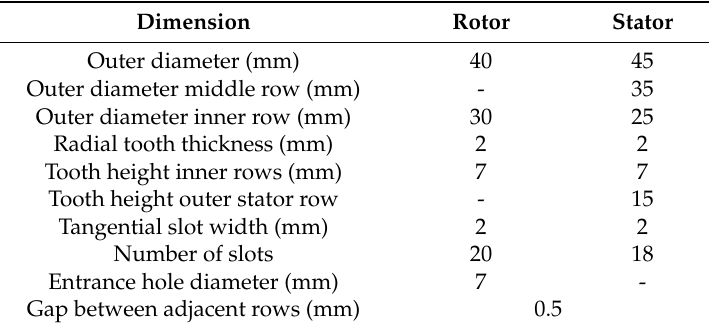
Figure 2. Rotor ( left ), stator ( middle ), and assembly ( right ). Important dimensions are given in Table 1. The clearance between the teeth and opposite base plate is small and somewhat dependent on the tightening of the screw. It was taken to be 0.1 mm in the simulations. Table 1. Dimensions of the S 50N rotor and stator. Dimension